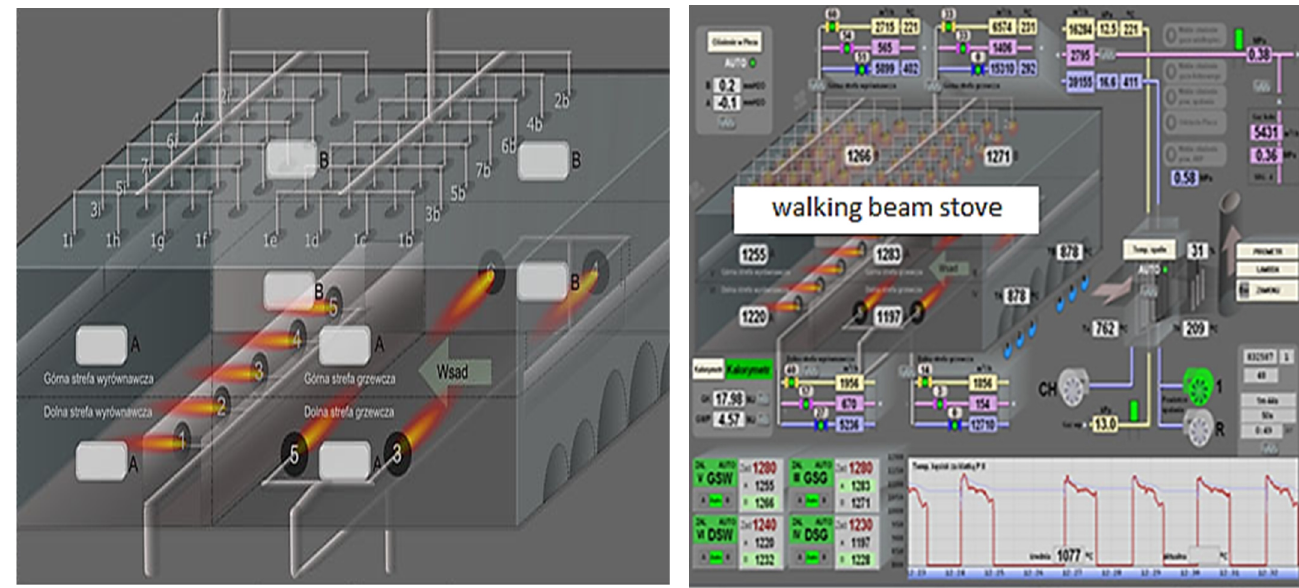
Figure 4. Walk-in furnace with different heating zones. Source: own study. Table 4. Thermal capacity of walking beam furnace zones of the hot strip